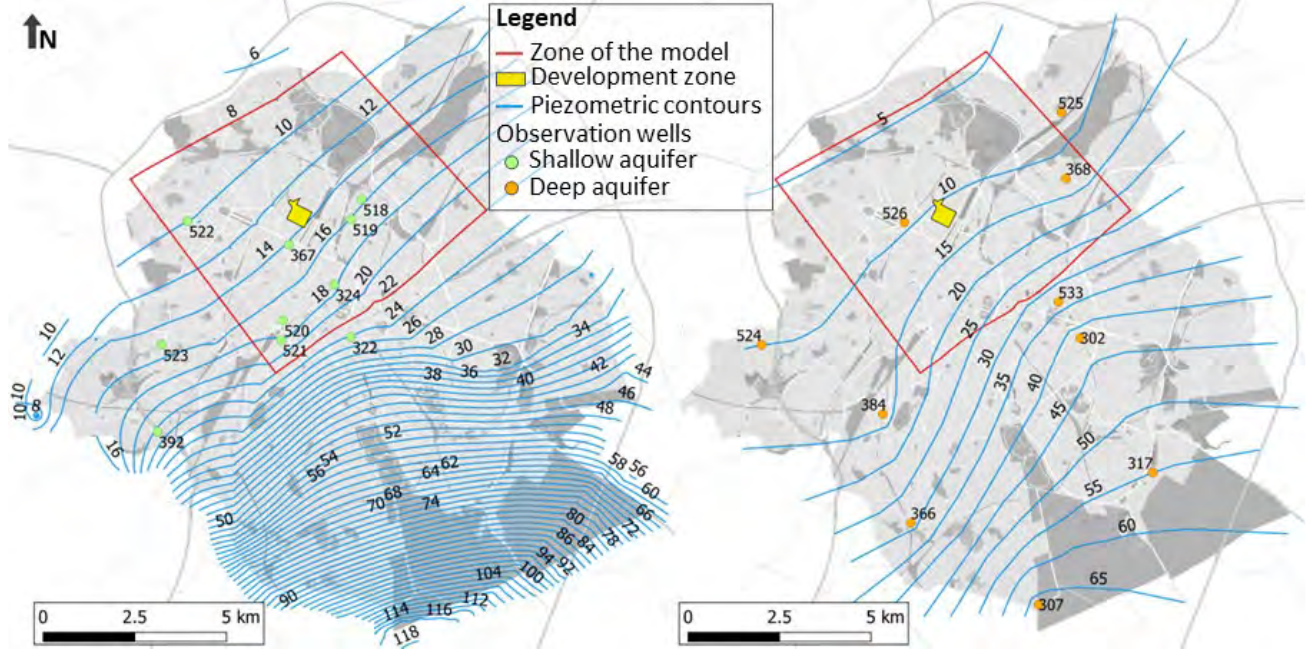
Figure 2. Observation wells and regional potentiometric maps in the shallow Cenozoic-Paleocene aquifer system ( left ) and in the deep Paleozoic bedrock aquifer ( right ).